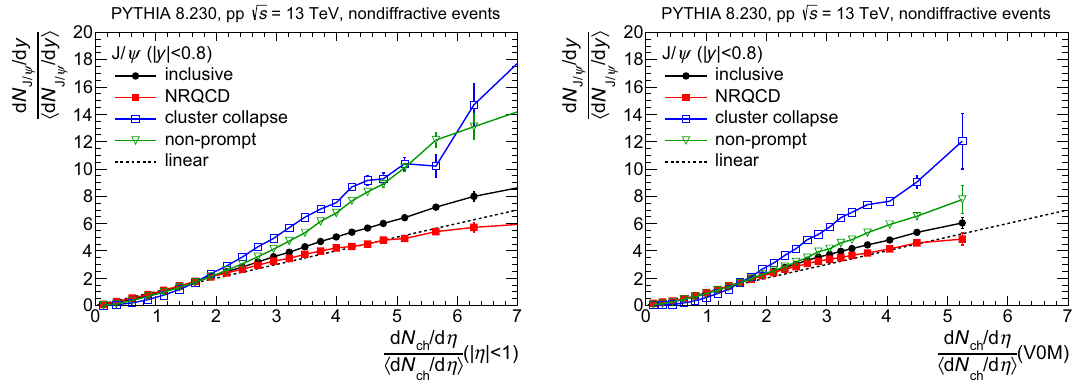
Fig. 6 Mid-rapidity J /ψ production as a function of charged-particle multiplicity at mid (left) and forward (right) rapidity split into the different production processes implemented in PYTHIA8, i.e. non-prompt J /ψ , prompt J /ψ from NRQCD and prompt J /ψ from cluster